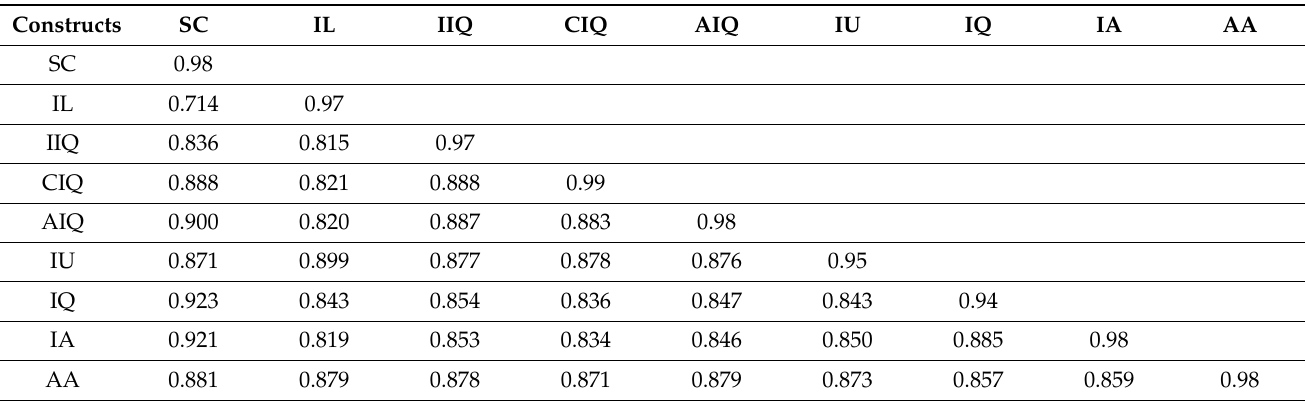
Table 6. Correlations of constructs.